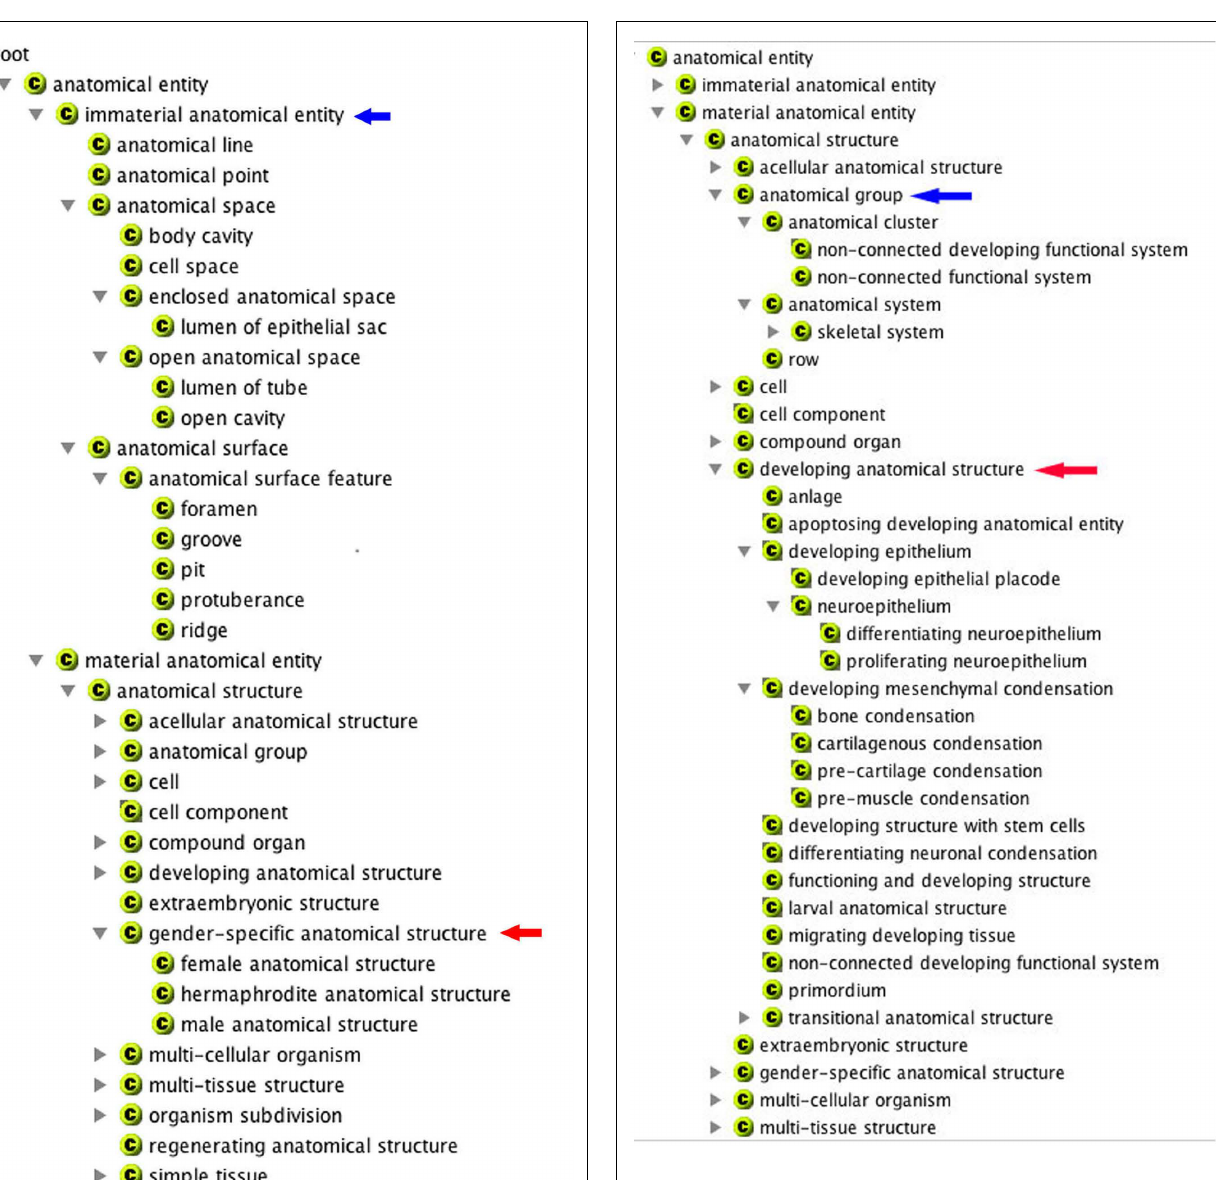
FIGURE 2 |TheAEO shown in the in the COBrA browser. Here, the hierarchies for anatomical group (blue arrow) and developing anatomical structure (red arrow) are